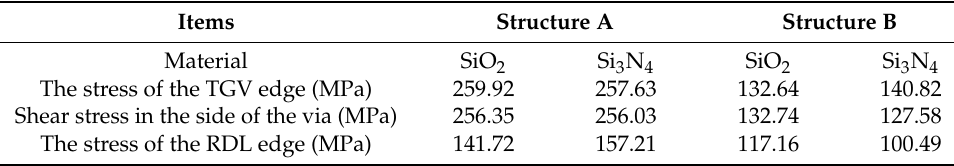
Table 3. Statistics of stress value with SiO 2 and Si 3 N 4 for the structure A and B.